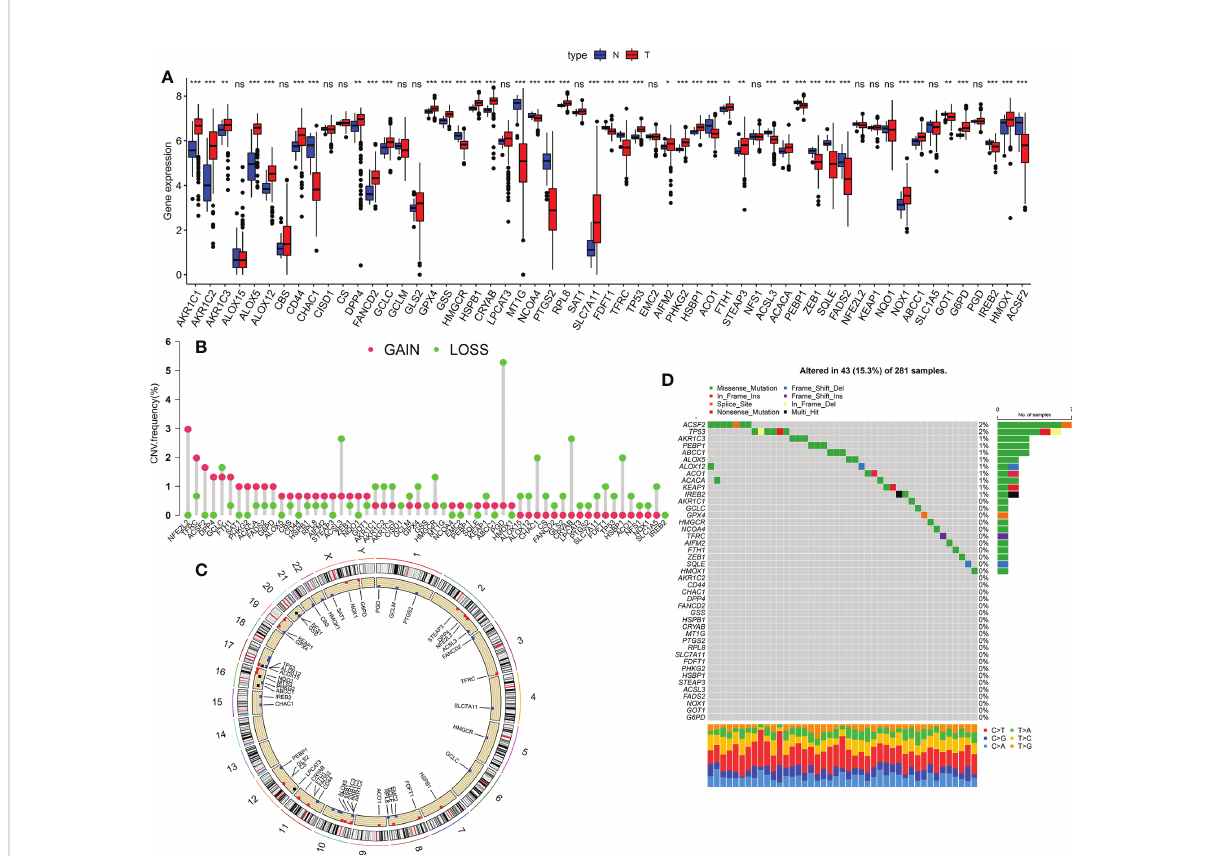
FIGURE 1 Genetic landscape of ferroptosis in KIRP. (A) The expression of FRGs between normal tissues and KIRP tissues. Red, tumour sample; blue, normal sample. (B) The CNV frequency of m6A regulators in the TCGA cohort. Red represents an increase in the copy number and green represents the loss of copy number. (C) Circle graph of the speci fi c location of the FRG. (D) The somatic mutation frequency of FRGs in patients with KIRP in the TCGA dataset * p < 0.05; ** p < 0.01; *** p < 0.001; n.s., not signi fi